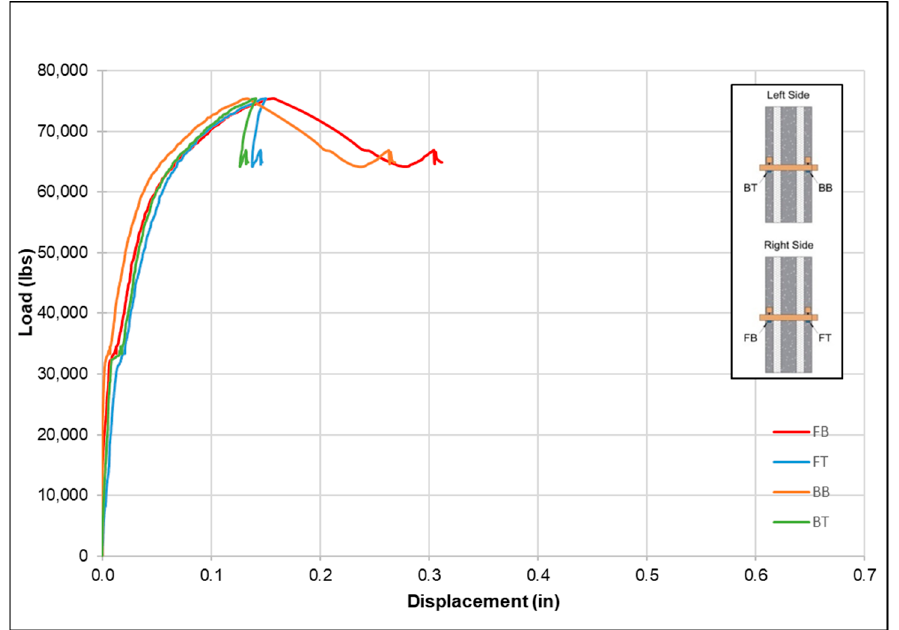
Figure 8. Load vs. displacement data from the four sensors for EPS.24.2.MMGRID.1.